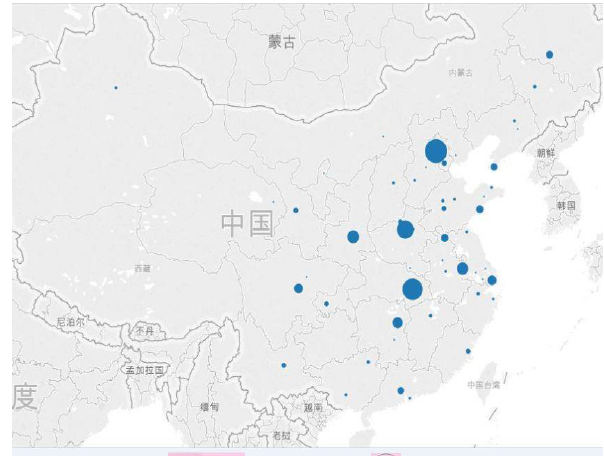
Fig.9 Geographical distribution(the number of paper